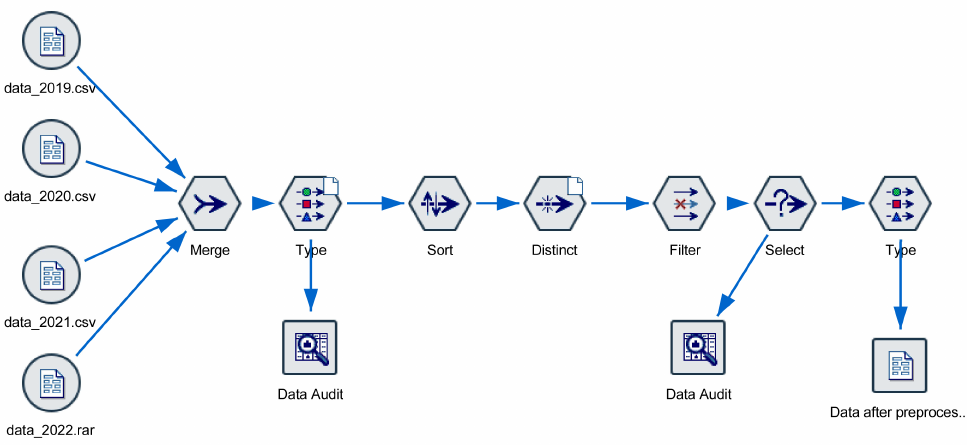
Figure 6. Data preprocessing stream with